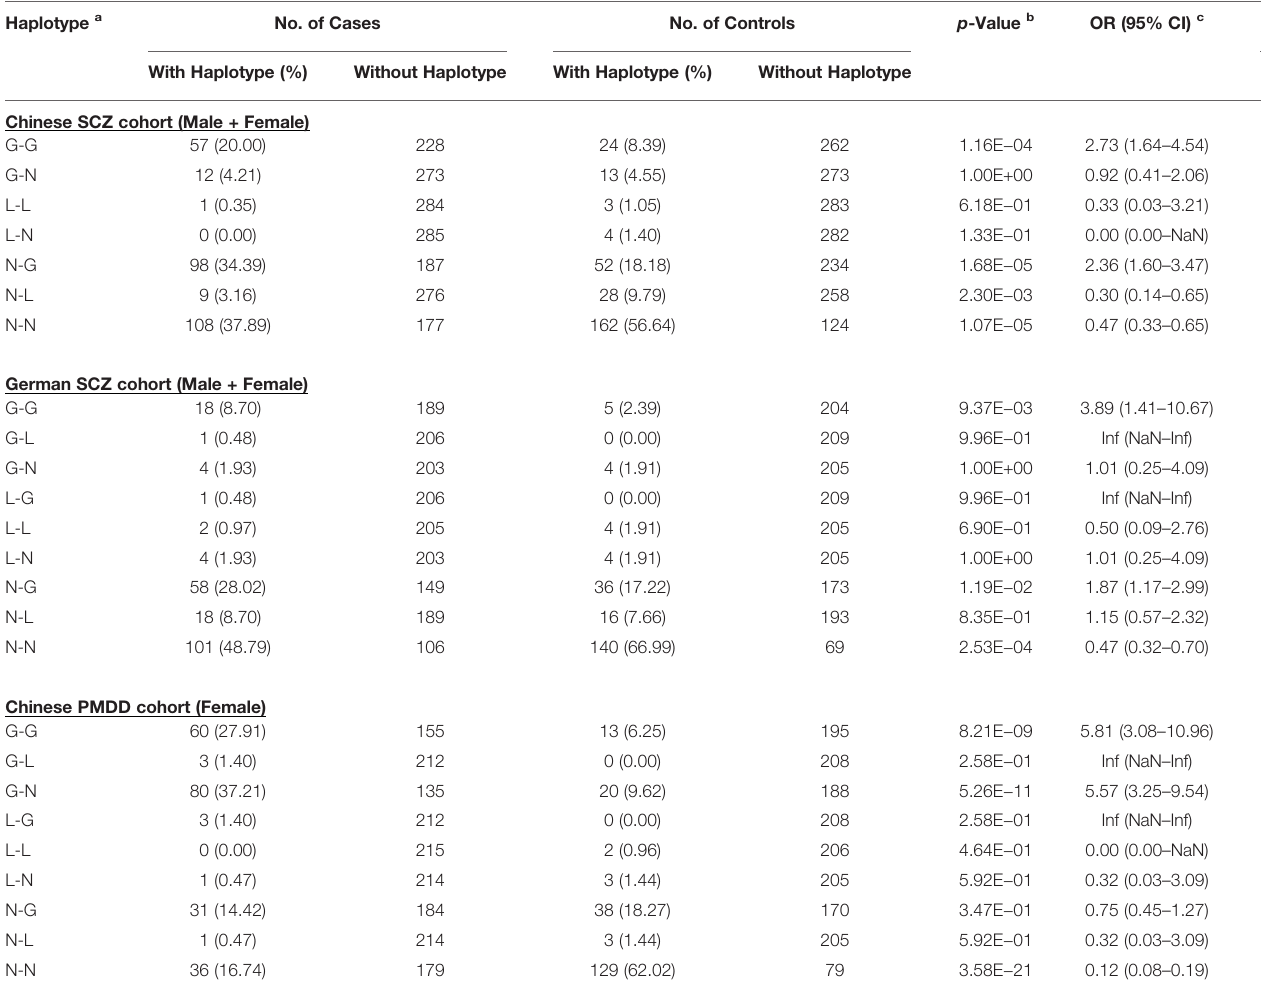
TABLE 4 | Haplotypes of copy number variations in SCZ and PMDD cohorts. Haplotype a No. of